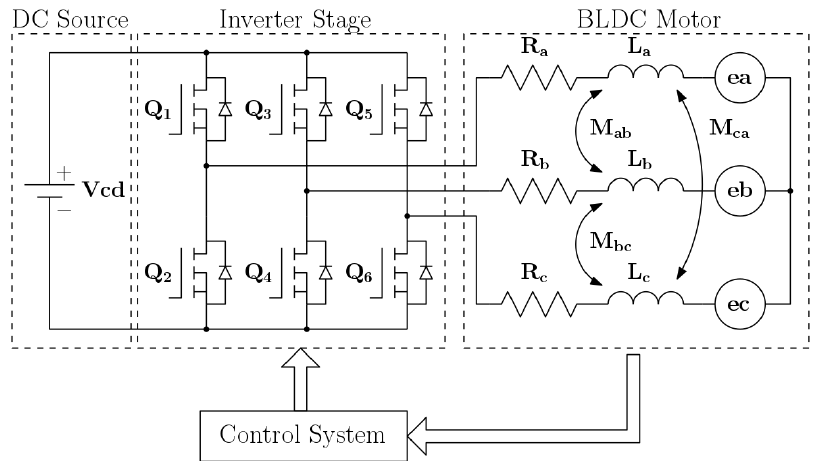
Figure 1. General block diagram depicting the main components of a Brushless Direct Current (BLDC) motor and its